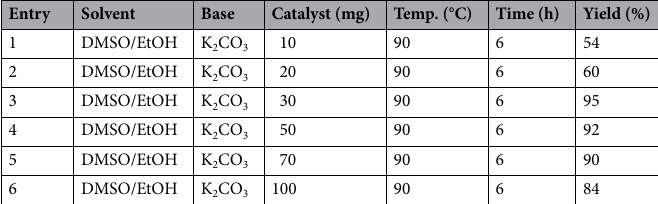
Table 3. Optimization of Cu@MCM-41-HPr-Met catalyst in model